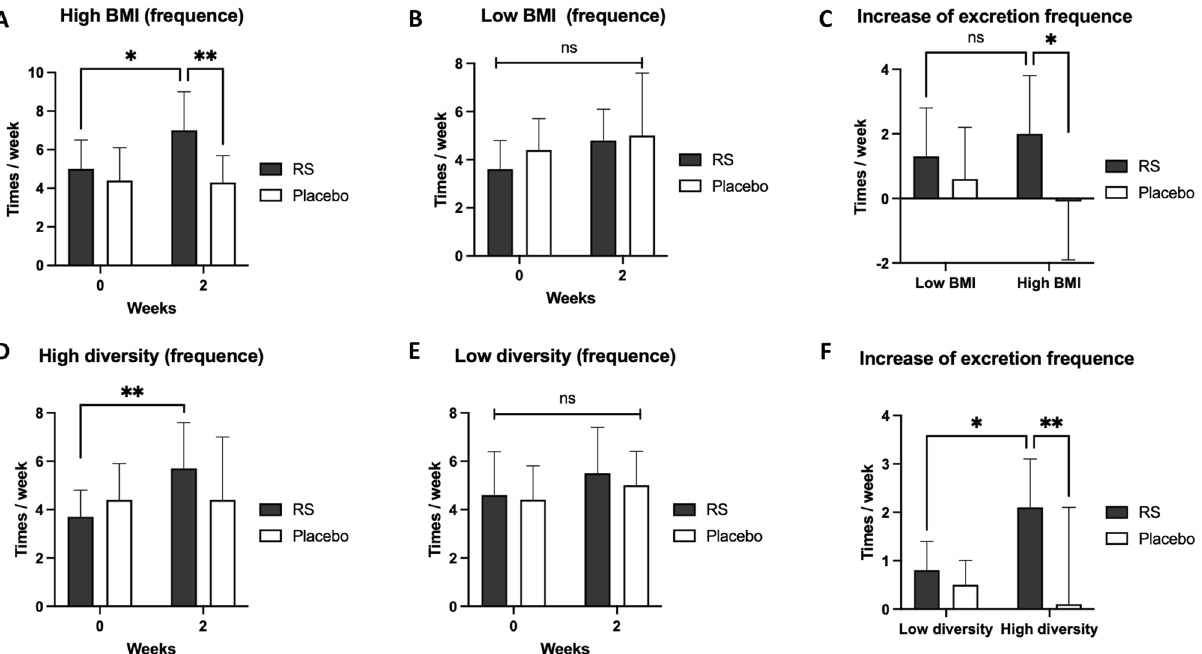
Figure 4. Sub-cluster analysis in human subjects. ( A , B ) In high BMI group ( A ), RS increased in excretion frequency/week at Week 2, which was not observed in low BMI group ( B ). ( C ) The increase of excretion frequency in high and low BMI group. * p < 0.05, ** p < 0.01. n = 7–12, error bars indicate SD. ( D , E ) In high diversity groups ( D ), RS increased in excretion frequency/week at Week 2, which was not observed in